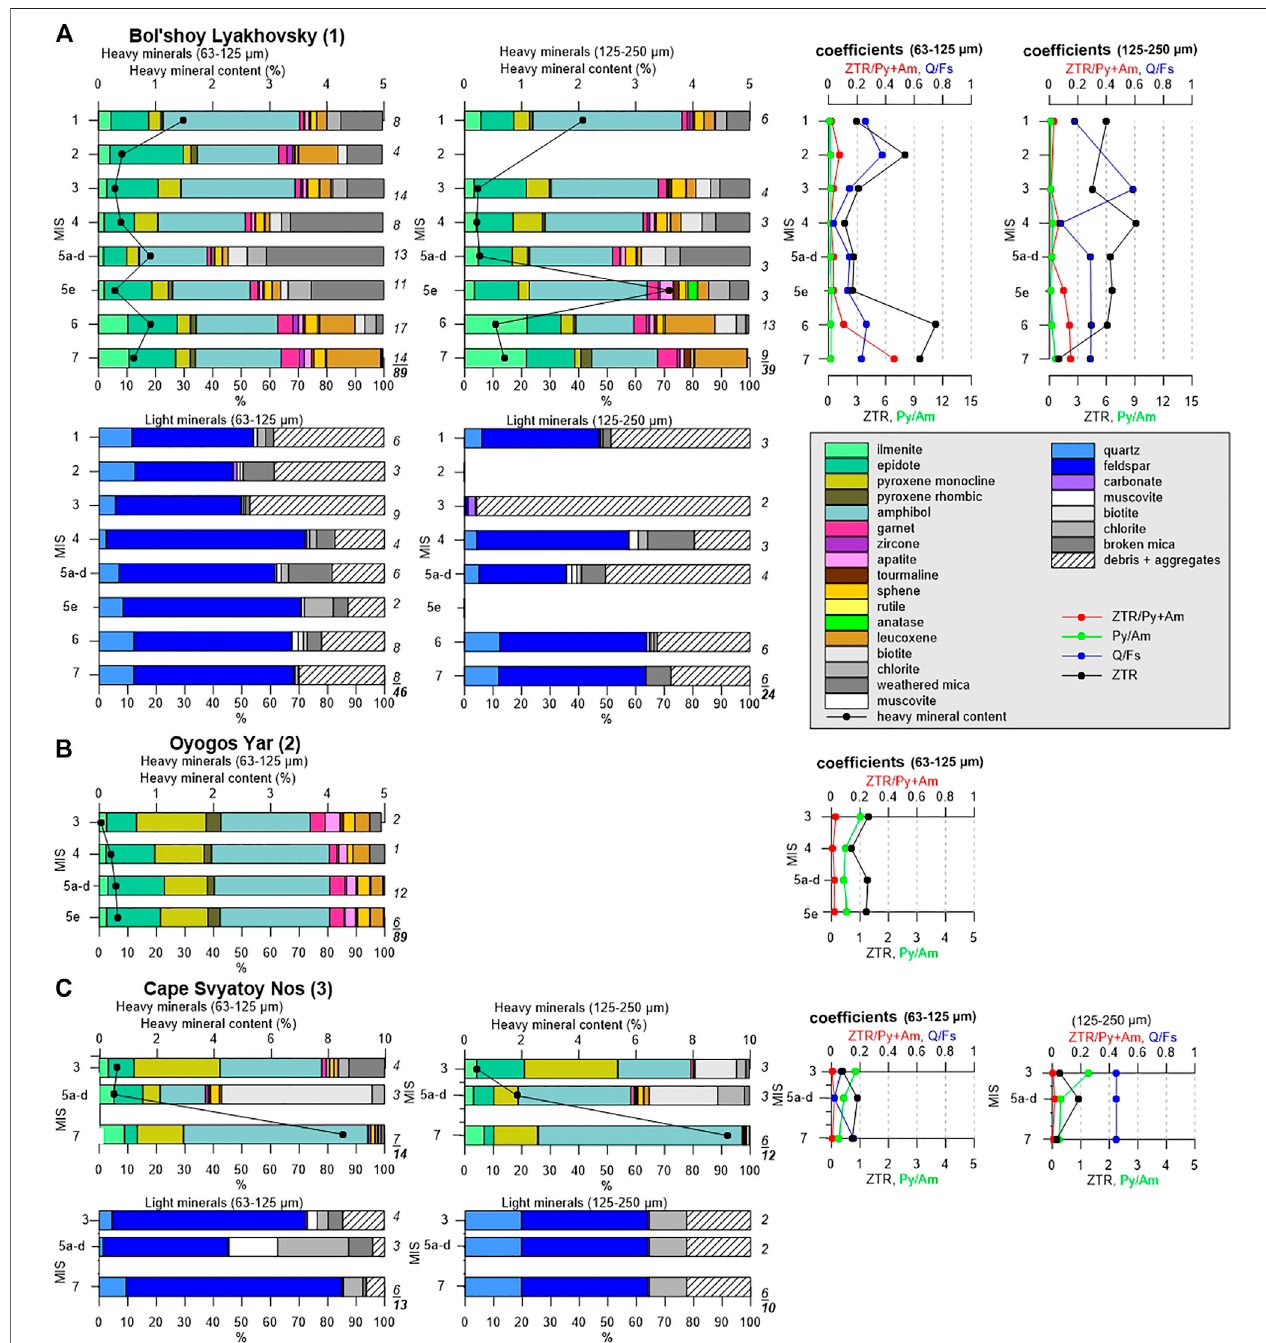
FIGURE 2 | Heavy and light mineral associations of the fi ne and coarse fractions, the heavy mineral contents, and the corresponding mineral coef fi cients from (A) Bol ’ shoy Lyakhovsky Island (1), (B) the Oyogos Yar coast (2), and (C) Cape Svyatoy Nos (3). The number of samples is in italics to the left of each diagram (Note the different scales for heavy mineral contents and the mineral coef fi